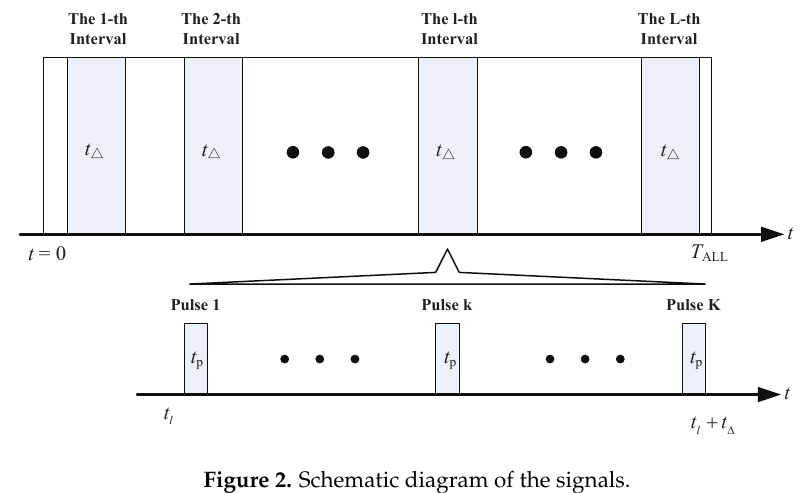
Figure 2. Schematic diagram of the